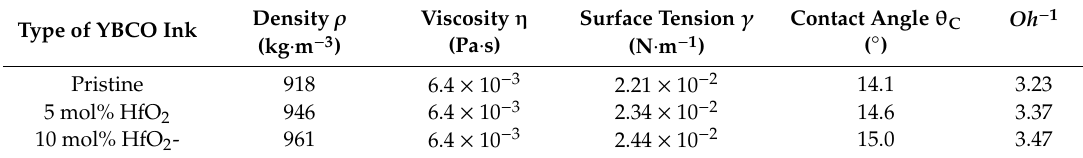
Table 1. Fluid properties of the di ff erent pristine and HfO 2 -YBCO inks for an orifice diameter ( α ) of 22 µ m, determined at 21 ◦ C.